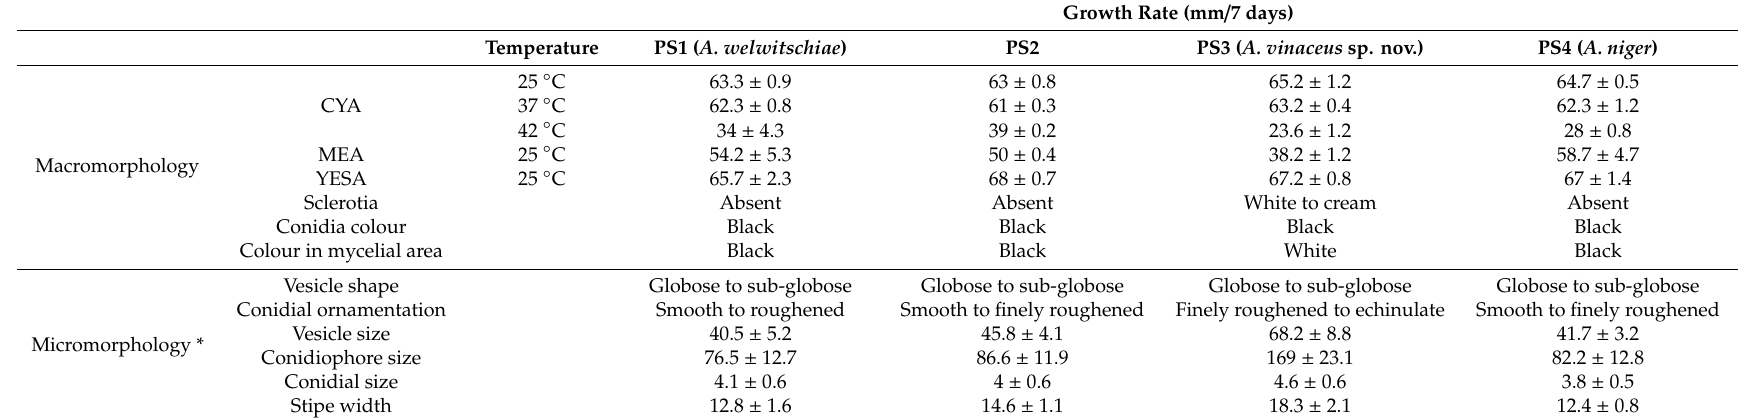
Table 2. Morphological characteristics of the phylogenetic species (PS) found in the A. niger